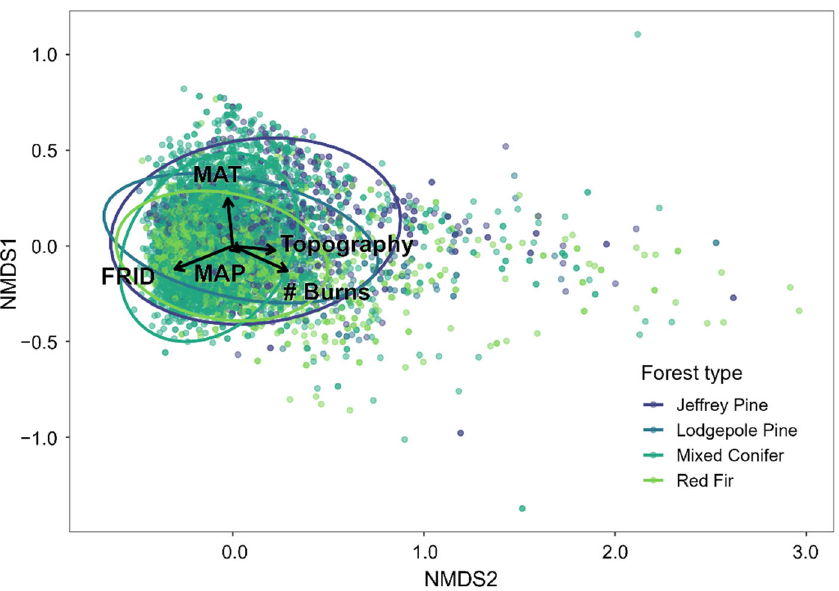
Figure 2. Non-metric dimensional scaling analysis of LiDAR-derived forest structure metrics. Arrows show the strength and direction of the relationship between multidimensional forest structure and mean annual temperature (MAT), mean annual precipitation (MAP), the number of fires (# Burns), fire return interval departure (FRID), and topographic context (Topography). Ellipses correspond to forest type, and their location is based on samples in ordination space.